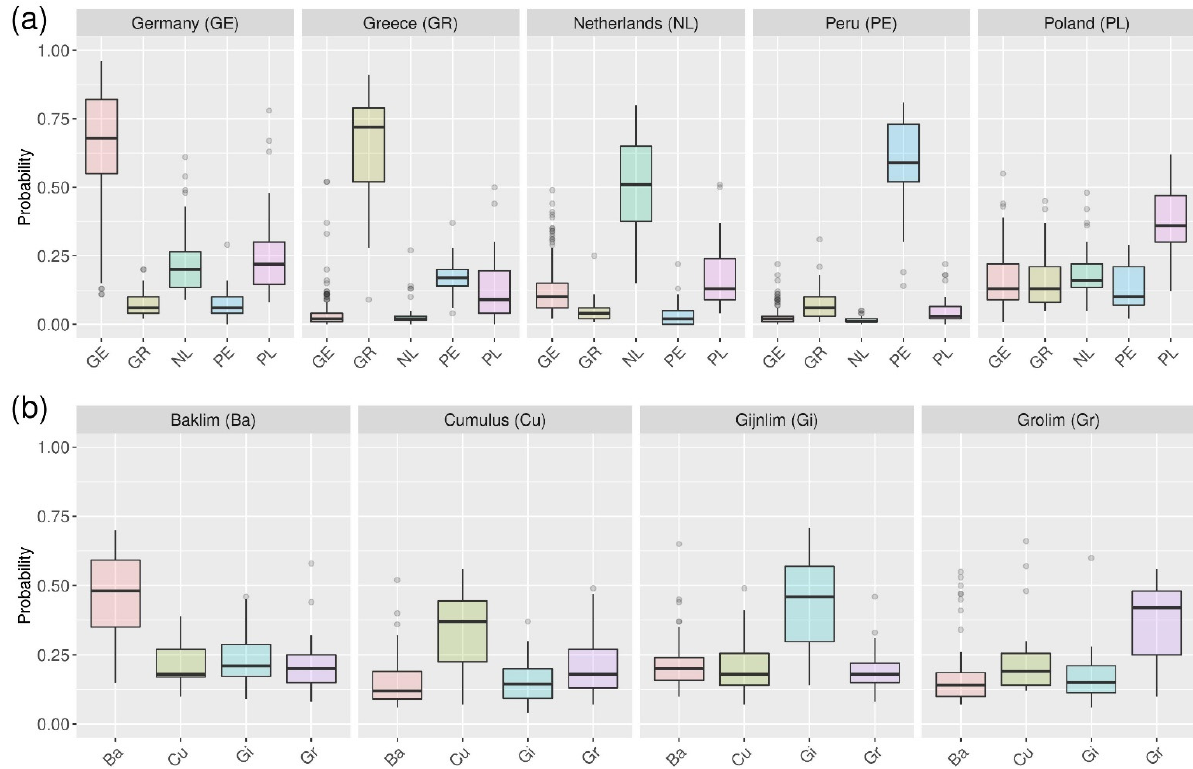
Figure 1. Results of the probability machines for the determination of the geographical origin ( a ) and the botanical variety ( b ). For the samples of each group (title), boxplots are shown that summarize the probabilities for the respective classes.